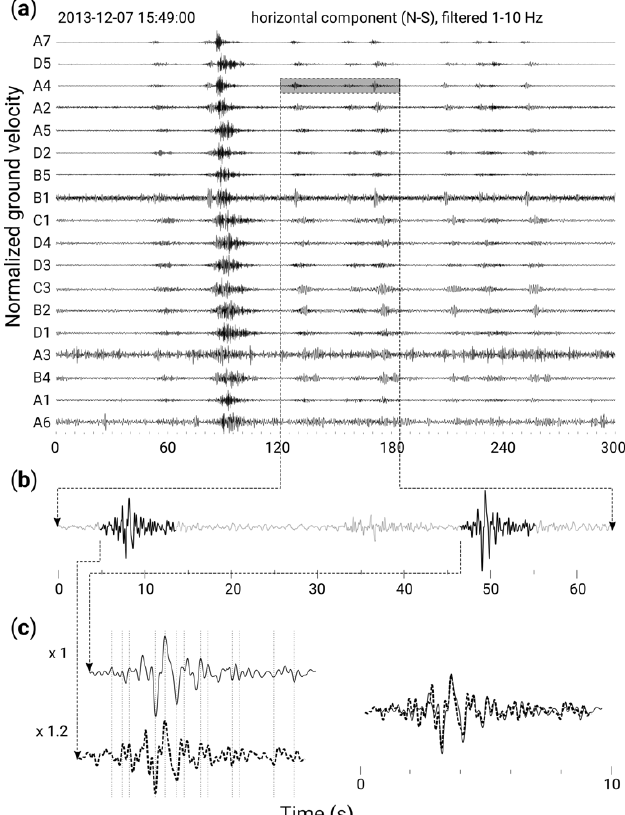
Figure 2. Example of LP swarm on Gorely: ( a ) 5-minute horizontal component records of 18 temporary stations; ( b ) zoom on representative LP signals at station A4; ( c ) close comparison of two waveforms.